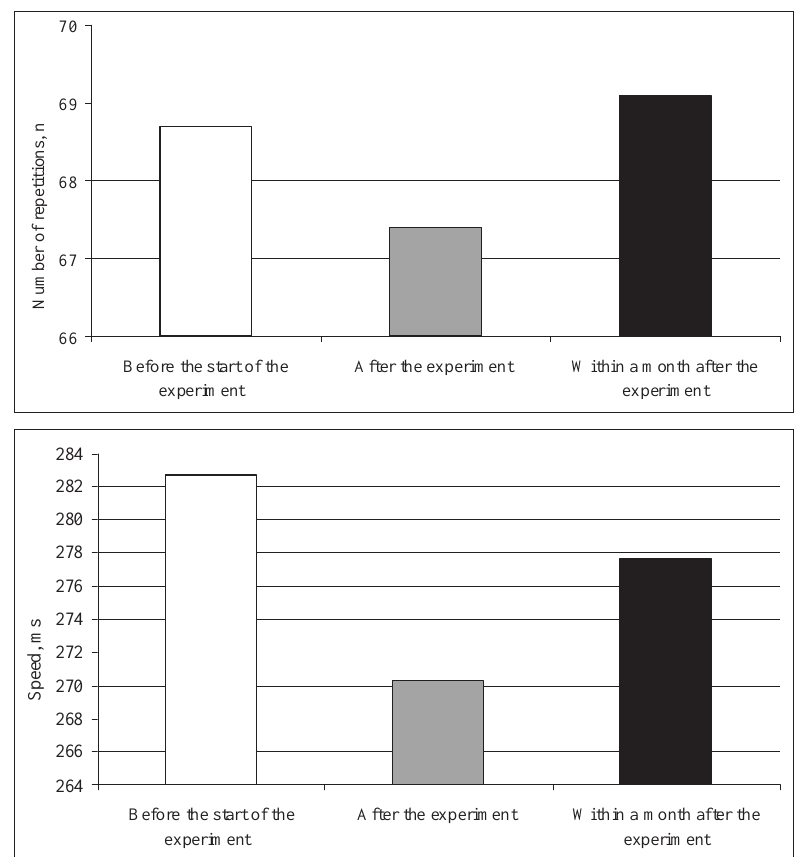
Figure 2. Dynamics of indicators of speed of the simple motor response (ms) before, after experiment and within 1 month after completion of the program of dosed vibra- tion